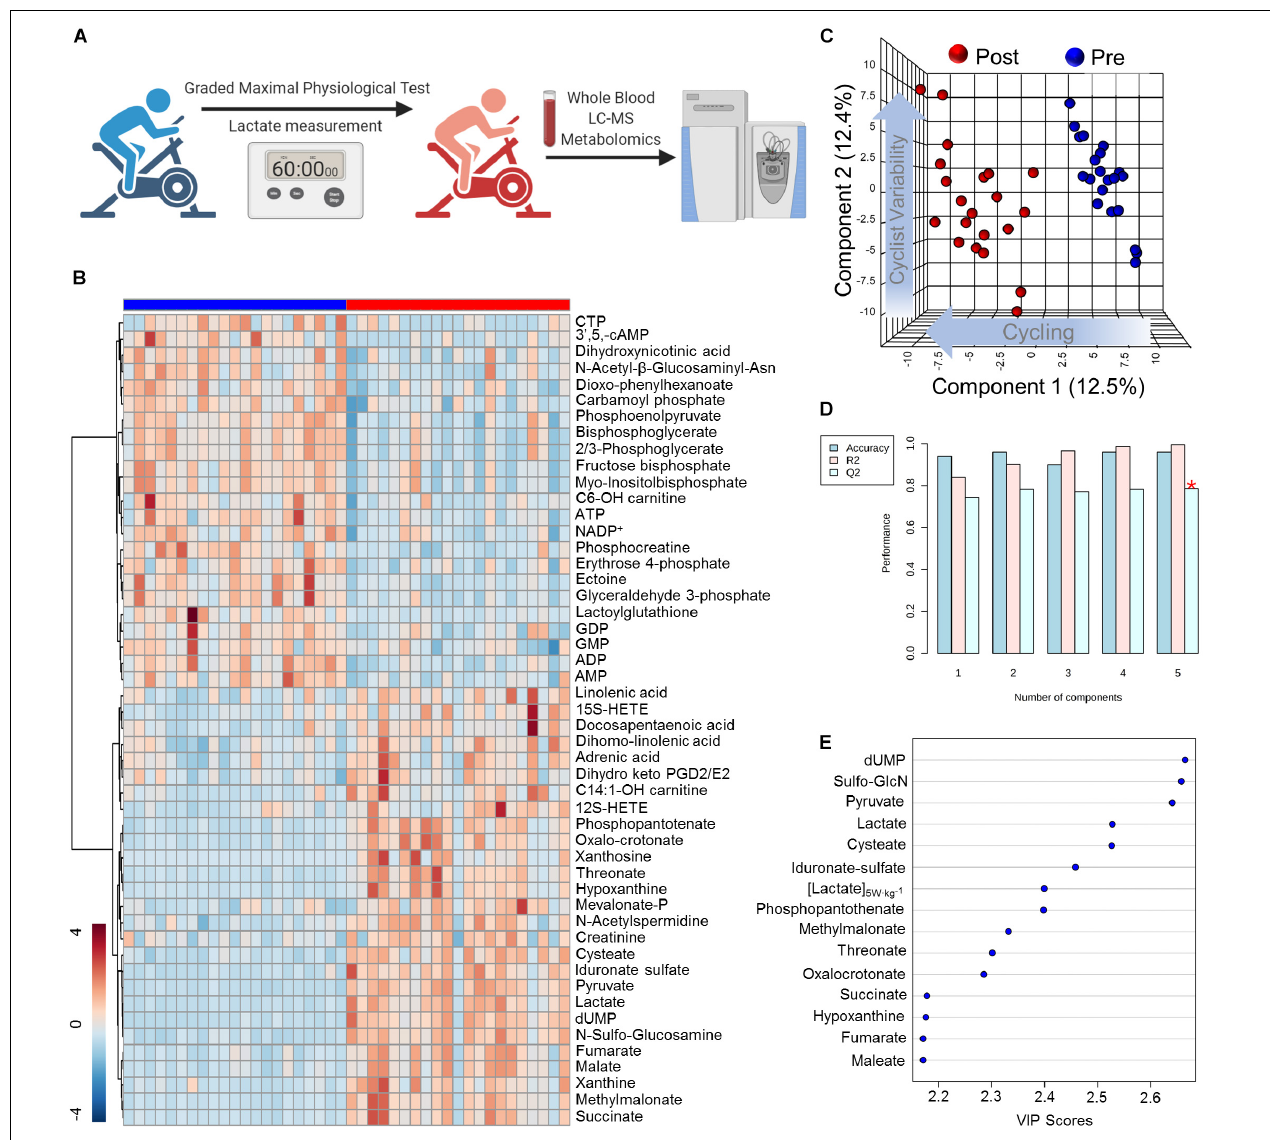
FIGURE 1 | High-Throughput Metabolomics of Endurance Training in Elite Professional Cyclists. (A) Blood samples were drawn from subjects using a TAP TM push-button blood collection device before and after 1 h of a graded exercise test. Samples were extracted for hydrophilic or non-polar metabolites and analyzed using a high-throughput LC-MS based metabolomics platform. (B) Hierarchical Clustering Analysis of the top 50 T-Test significant metabolites is shown as a heat map and are Z-score normalized, with the color-coded gradient depicted in the lower left corner. (C) Partial Least Squares Discriminant Analysis (PLS-DA) shows a distinct clustering pattern of baseline (Pre, blue) and post-test (Post, blue) samples along Component 1 axis (12.5% variance explained), while inter-individual variability is described by the Component 2 axis (12.4% variance explained). (D) PLS-DA cross validation details are shown for the first 5 components. (E) Parameter with the top 15 variable importance in projection (VIP) scores are